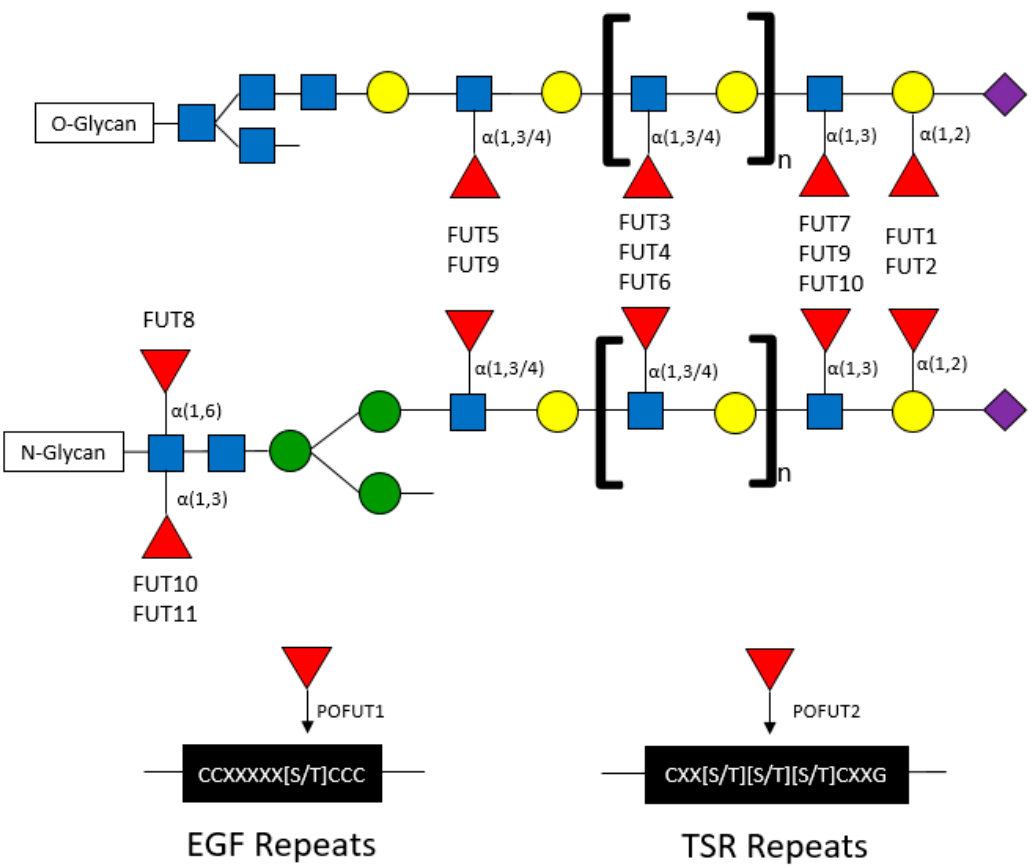
Figure 2. Fucosyltransferases and their associated conjugated fucose structures.